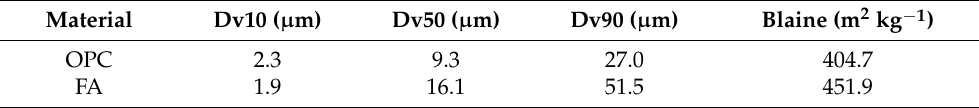
Table 3. OPC and FA particle size distribution and Blaine